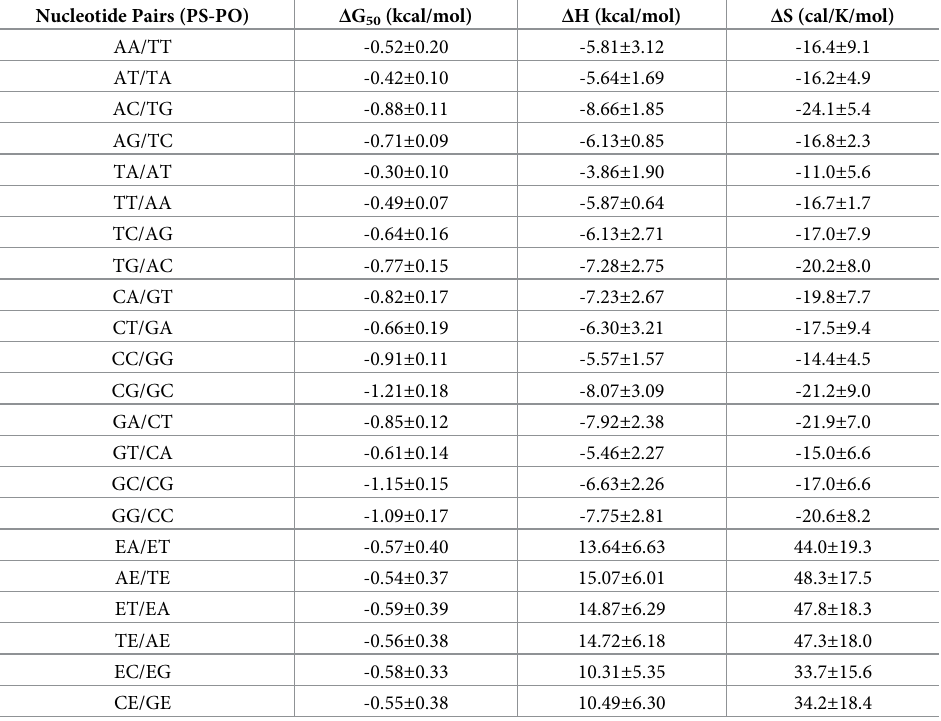
All reported values are adjusted to 1 M NaCl and 50˚C. All internal nucleotide parameters have a PS linkage between the top nucleotide pair (e.g. 5’A � A/3’TT). Errors are defined as the standard deviations of the parameter fits. Parameter values are non-unique solutions from the model